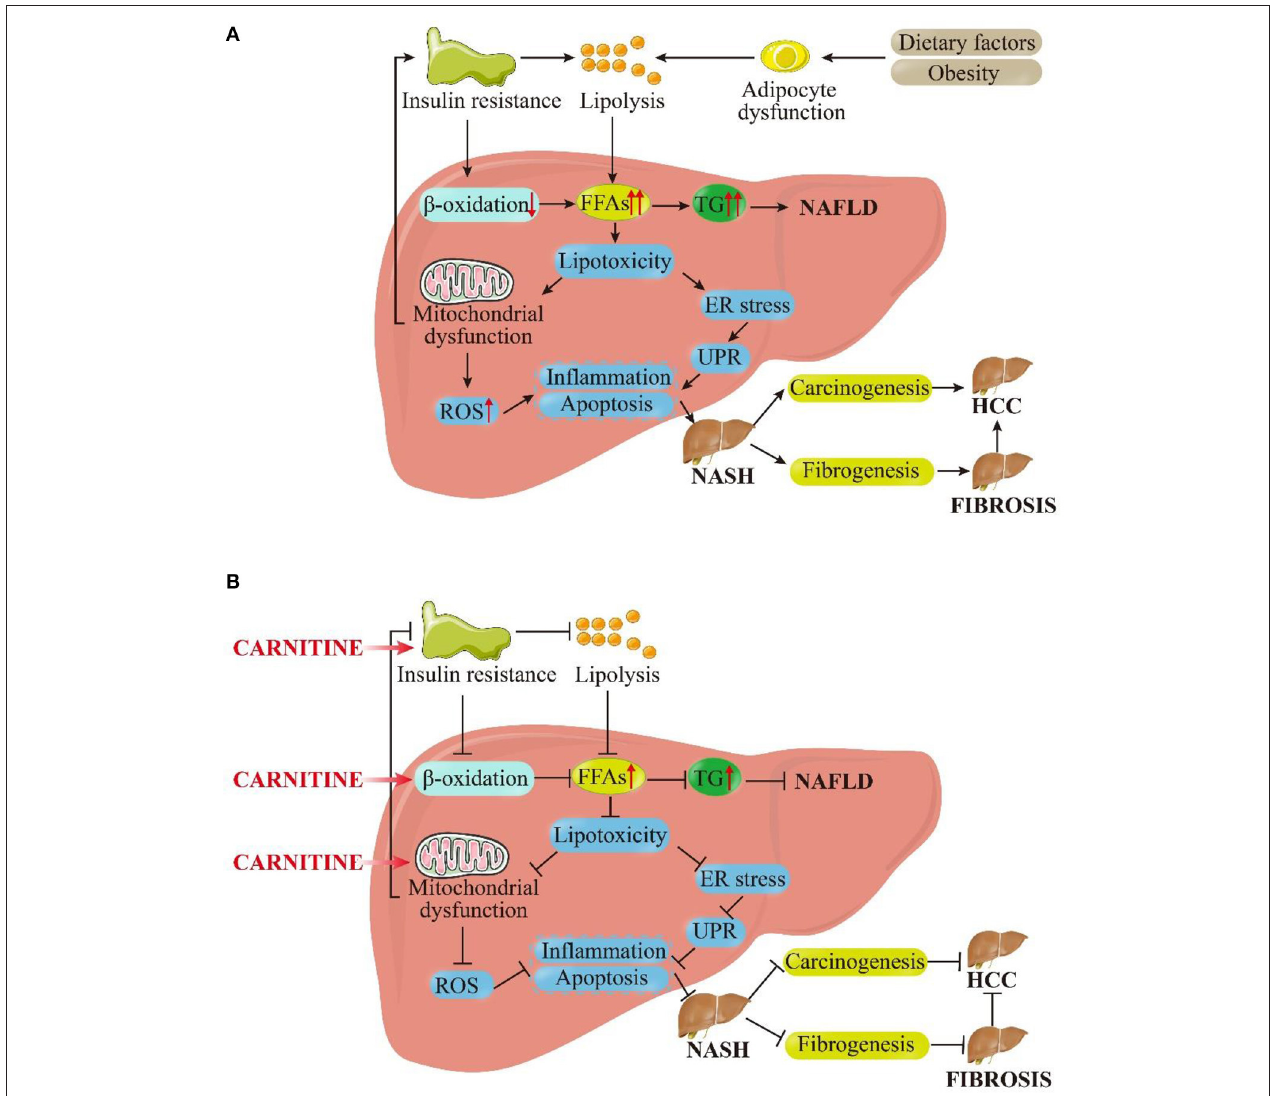
FIGURE 3 | Pictorial representation of the (A) pathophysiological mechanism of NAFLD based on the “multiple hit” hypothesis and (B) inhibitory effects of carnitine on NAFLD and its progression. As shown in (A) , dietary and environmental factors, together with obesity, lead to the proliferation and dysfunction of adipocytes. Insulin resistance acts on adipose tissue and worsens adipocyte dysfunction, which in turn worsens lipolysis. In the liver, insulin resistance inhibits β -oxidation. Under the dual attack of increased lipolysis and weakened β -oxidation, the influx FFAs to hepatocytes is increased greatly, leading to the synthesis and accumulation of TG and enhanced liver lipotoxicity. Excessive TG eventually induces NAFLD. Increased lipotoxicity leads to mitochondrial dysfunction and oxidative stress on endoplasmic reticulum (ER) by the activation of ROS, which leads to liver inflammation and fibrosis. At the same time, mitochondrial dysfunction promotes insulin resistance, exacerbating above process in a vicious circle. These pathological processes can cause the liver to persist in the stable stage of disease (NAFLD) or develop in to NASH. In the late stage of disease progression, NASH can progress to fibrosis or even HCC under the stimulation of certain factors. As shown in (B) , carnitine supplementation reduces insulin resistance, promotes β -oxidation and improves mitochondrial function. Subsequently, the cellular concentration of FFAs and TG in hepatocytes get reduced and lipotoxicity is alleviated. The level of ROS is restrained to a certain extent, and inflammation and apoptosis were also improved. These above interlocking effects could alleviate NAFLD and NASH, and they may even have positive therapeutic effects on liver fibrosis and HCC. FFAs, free fatty acids; TG, triglycerides; ER, endoplasmic reticulum; UPR, unfolded protein response; ROS, reactive oxygen species; NASH, non-alcoholic steatohepatitis; HCC, hepatocellular